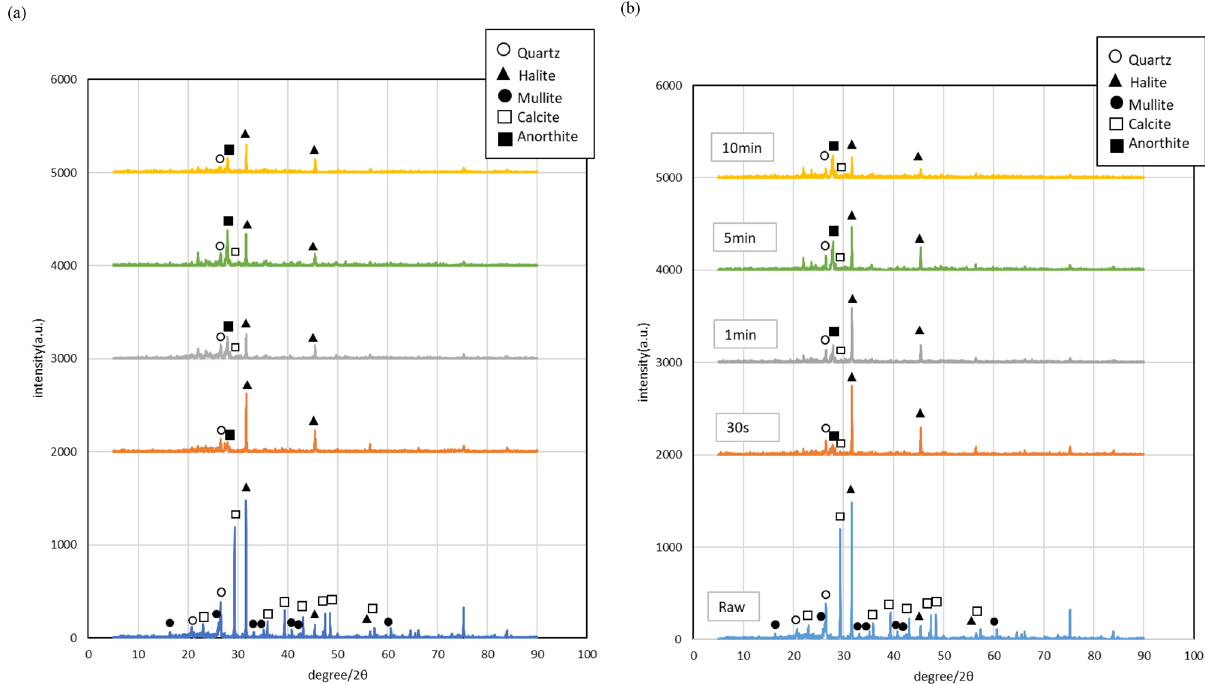
Figure 4. XRD patterns of the water-added mixture ( a ) after microwave electric field heating and ( b ) after microwave magnetic field